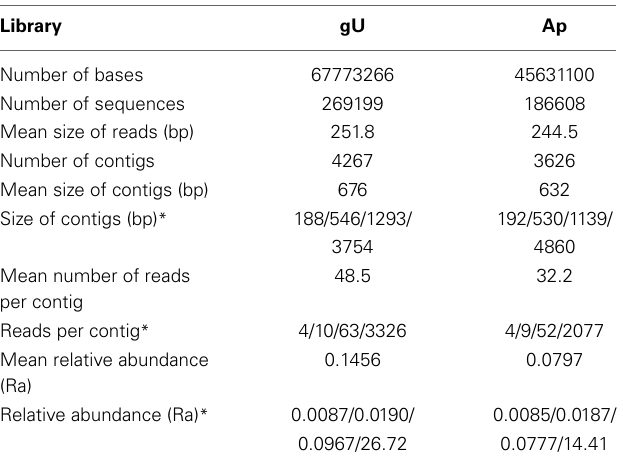
Table 1 | Descriptive statistics for Hemileia vastatrix 454 pyrosequenced cDNA libraries of germinated urediniospores (gU) and appressoria (Ap).